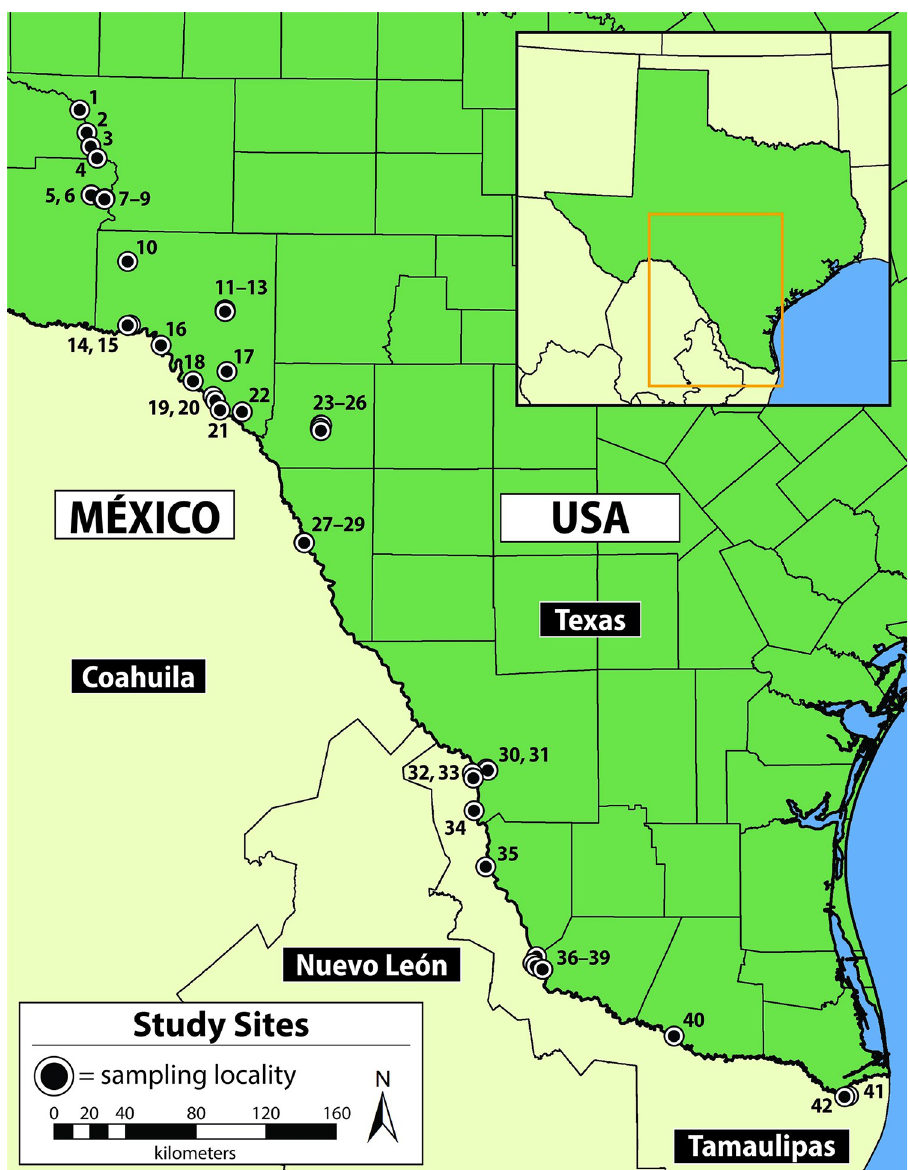
Fig 1. Map of drone sampling localities. Drone surveys for Pseudemys gorzugi (and sympatric turtles) occurred at 42 unique localities throughout southwestern Texas, USA. Site numbers correspond to those used in Tables 1 and S1.